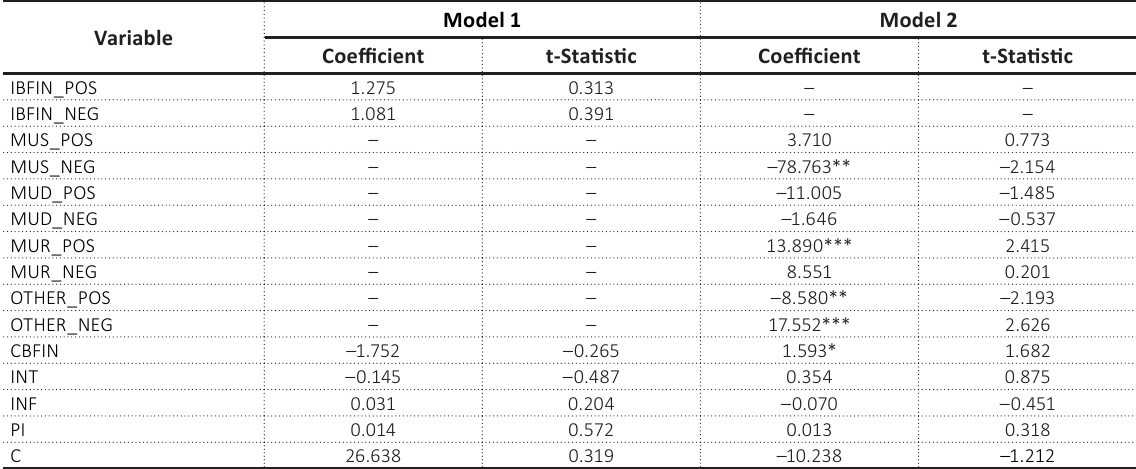
Multiplier for LNMUS(+) Multiplier for LNMUS(–) Asymmetry Plot (with C.I.)